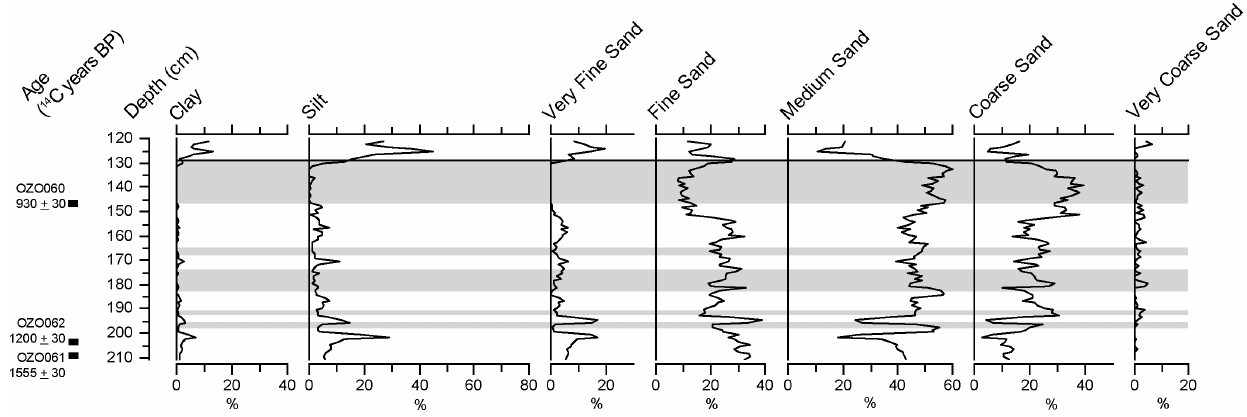
Figure 4. Mineral particle size analysis of core TMR/B. Gray shading represents sand beds. Particle size classification follows the Wentworth classification scheme [56].